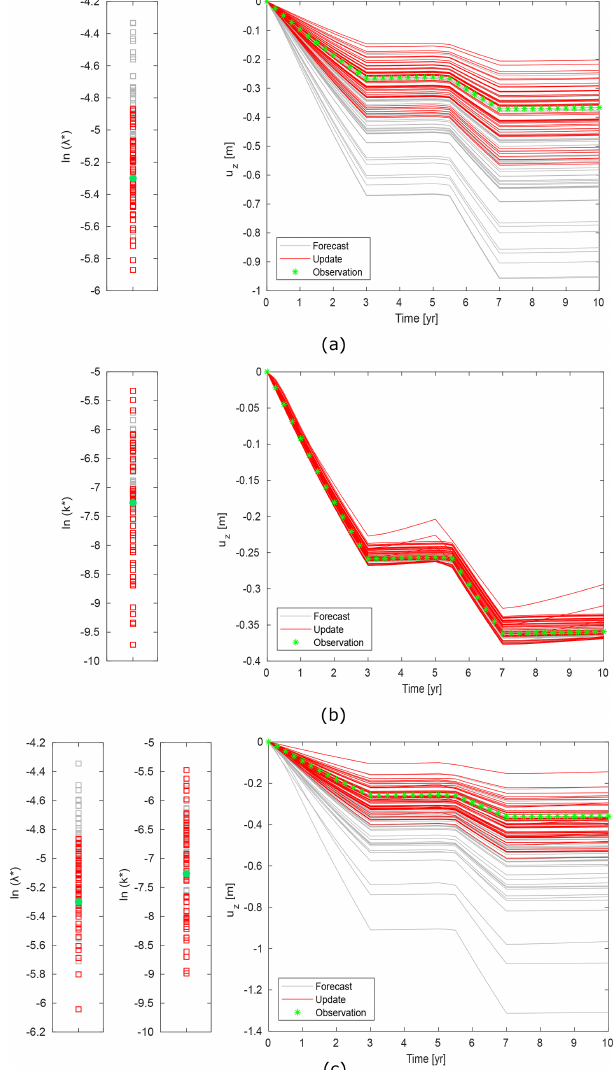
Figure 1. Outcomes of ES for set #1 (a) , #2 (b) and #3 (c) . Pa- rameters (left panels) and state, i.e. vertical displacements, u z (right panels), ensembles are shown in grey (forecast) and red (update). Observation data are green